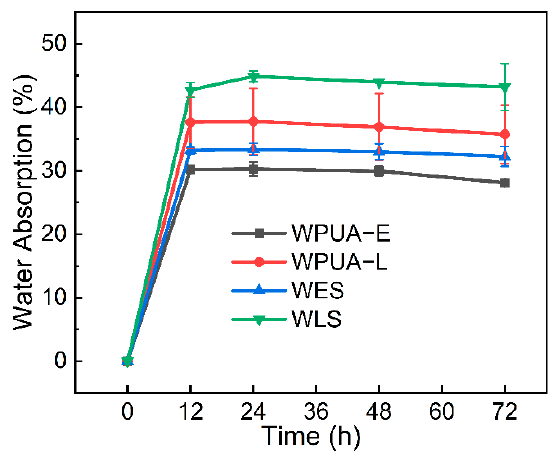
Figure 7. The water absorption of WPUA films.